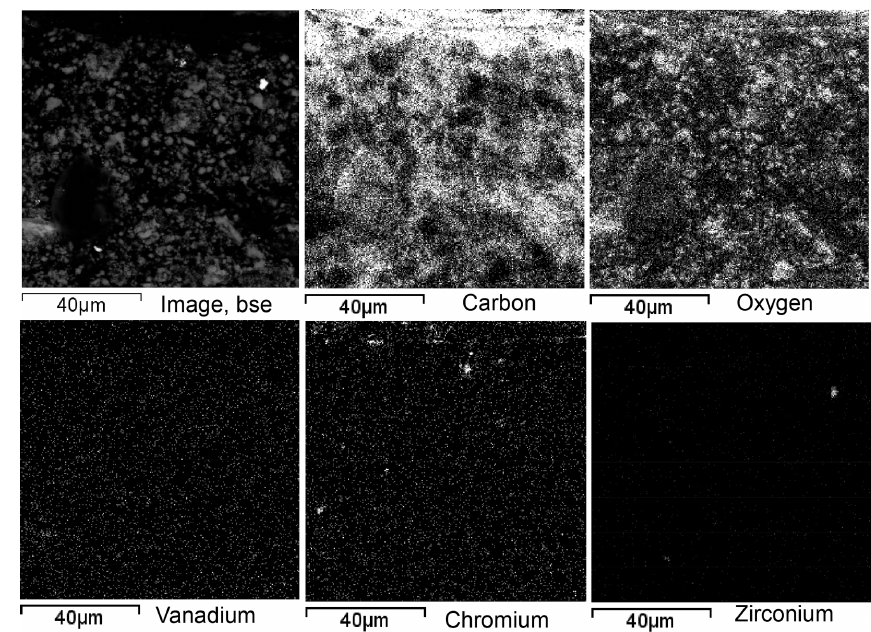
Figure 7. Element distribution maps of the region shown in the backscattered electron (BSE) image of ShR1.